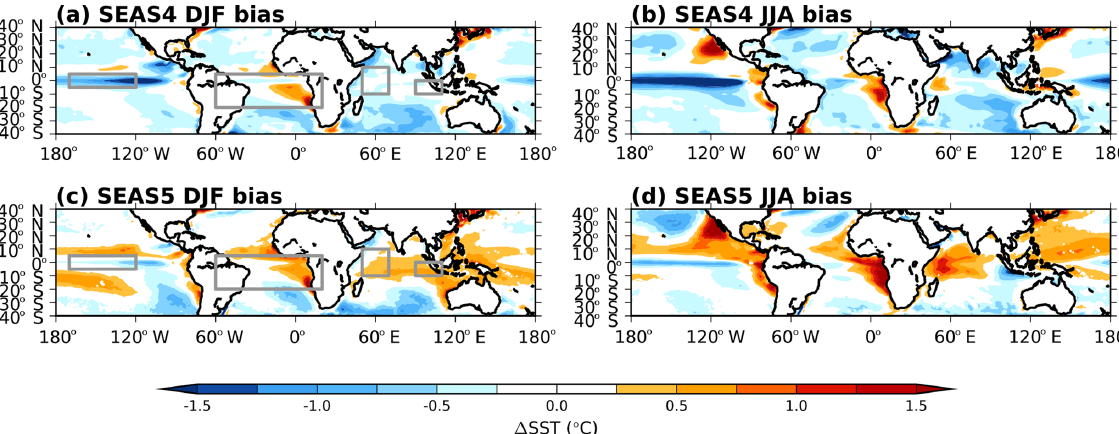
Figure 1. DJF and JJA SST bias in the tropics at 1-month forecast lead for SEAS4 (a, b) and SEAS5 (c, d) compared to the analysis they were initialised from (ORAS4, ORAS5). The regions discussed in detail later in this section are outlined in grey here.